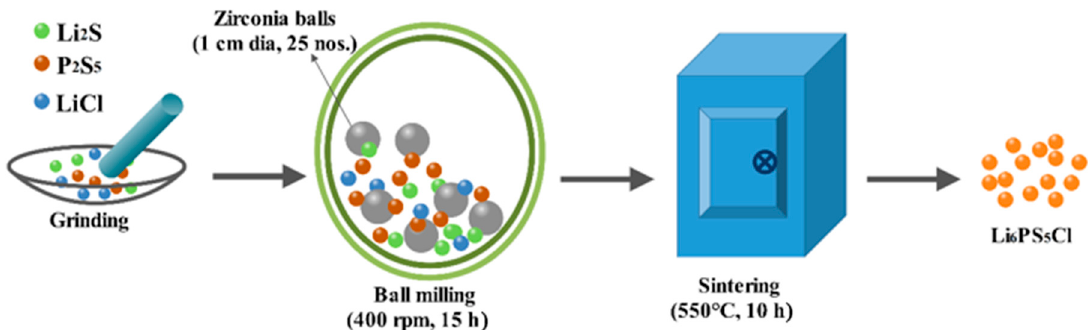
Scheme 1. Schematic illustration of preparation of the Li 6 PS 5 Cl solid electrolyte.